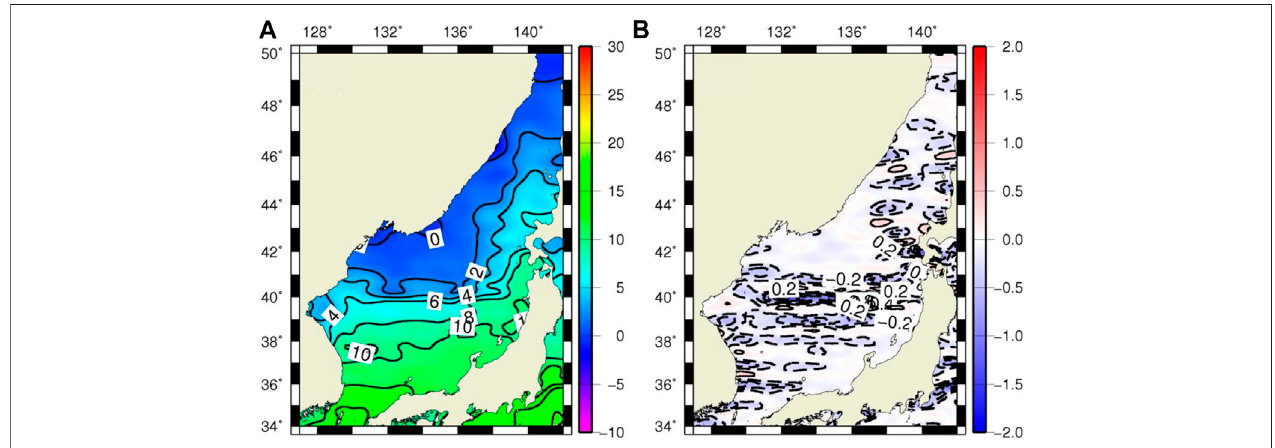
FIGURE3 | (A) Horizontal temperature distribution and (B) meridional temperature gradient at surface in February. Thisis anew optimal interpolation product with 0.1 ° resolution using both 1 ° gridded WOA13 and irregular WOD13. In fl uence radius applied was 211 km (zonal) and 111 km